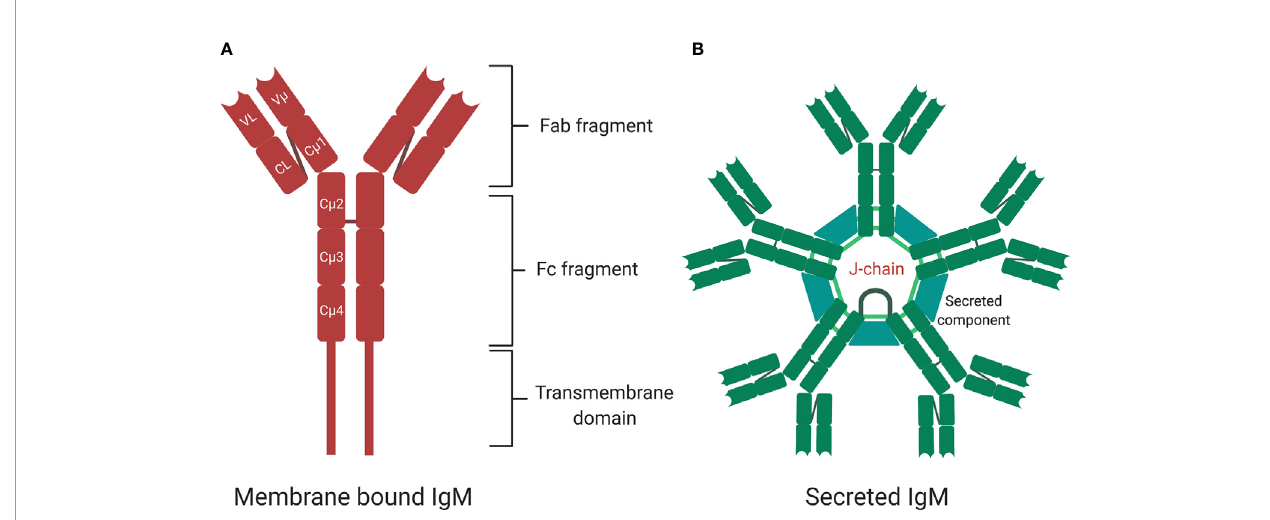
FIGURE 2 | The structure of membrane bound and secreted immunoglobulin M (sIgM). (A) A monomer structure of immunoglobulin M (IgM) contains Fab fragments, Fc fragment, and transmembrane signaling tail that attaches to Fc receptors on the surface of B cells. A monomer is made up of two heavy chains and two light chains. (B) A pentamer structure is the most naturally occurring form with fi ve monomers held together by a J-chain. Secretary component regulates surface availability and secretion of the pentamer. Created with BioRender.com.